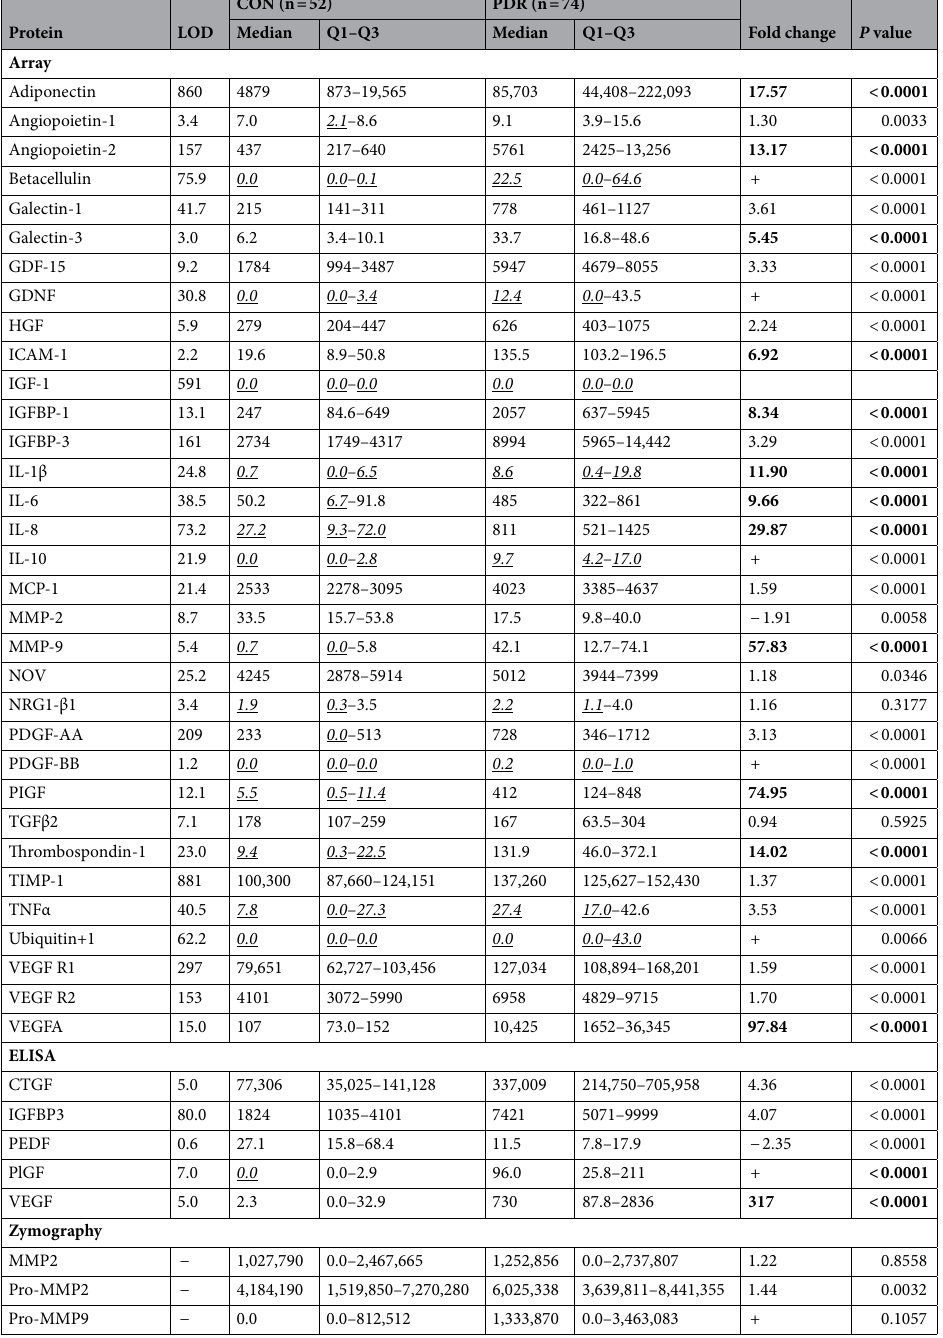
Table 2. Protein concentrations in vitreous of control and PDR patients. PEDF data is presented in µg/ml, Zymography data is expressed as intensity of bands in arbitrary units. All other protein data are presented in median pg/mL with 1st and 3rd quartile values. BDL, below limit of detection (LOD). Levels that are lower than LOD are underlined and indicated in italics, and should be considered less reliable. Fold changes with ’+’ present values in PDR that are higher as compared to controls with zero median levels. The Mann–Whitney U test was used to assess statistical differences between PDR and control patients. Fold changes higher than 5-fold and a P-value < 0.001 are indicated in